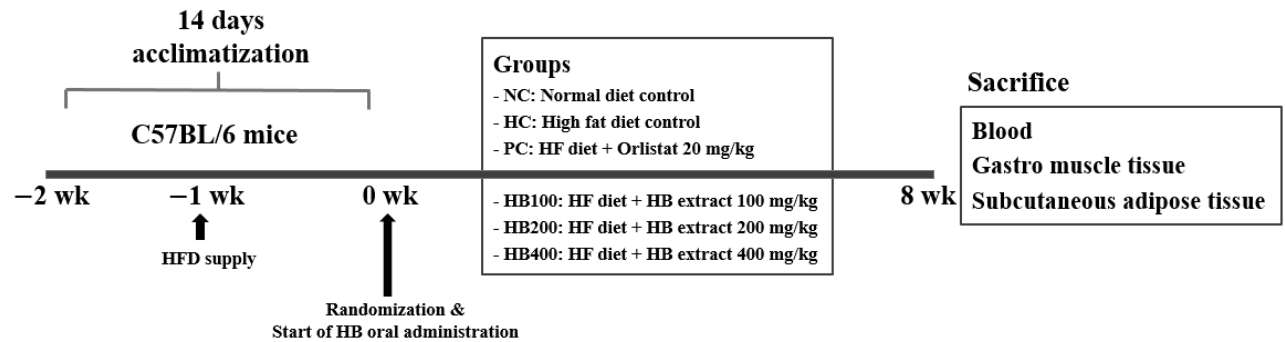
Figure 1. Experimental design of the study.